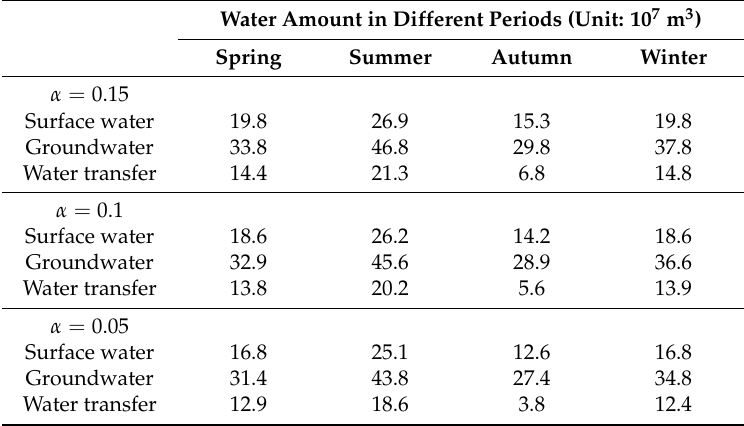
Table 6. The available water flows under different α levels.